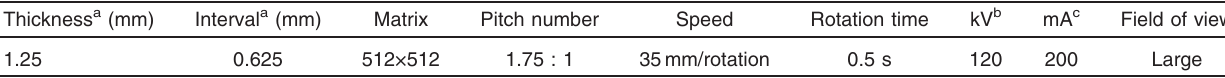
Table 1 The different parameters used in the computed tomography technique Thickness a